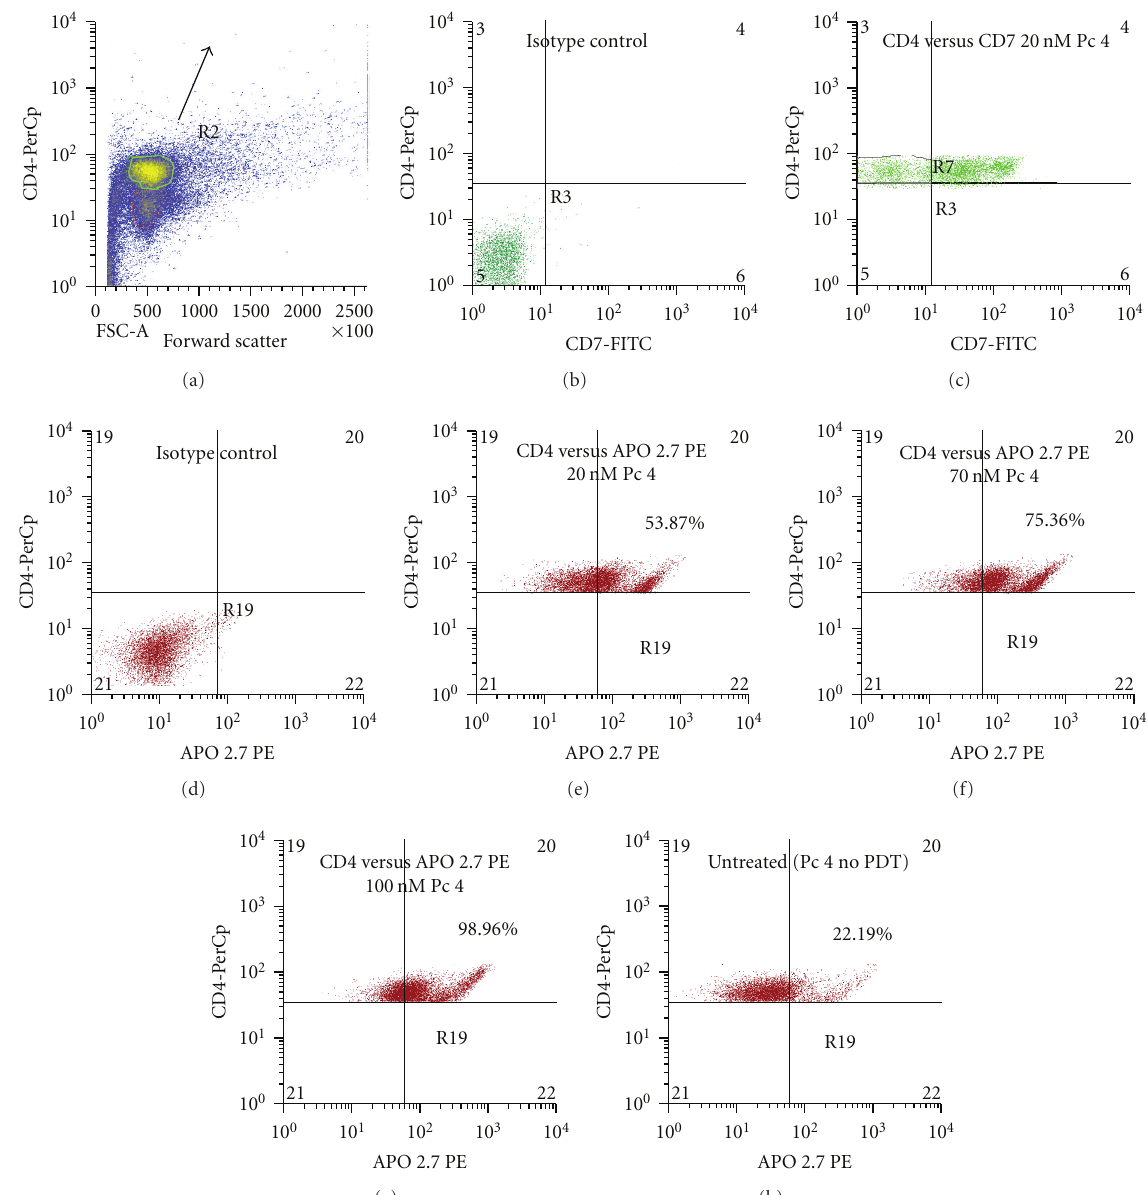
Figure 2: Representative flow cytometric histograms of the induced apoptosis of CD4 + CD7 − lymphocytes treated with Pc 4-PDT. Total blood was obtained from patients diagnosed with Sezary syndrome. The histograms shown were taken from a single patient with SS. PBMCs were isolated, treated with Pc 4, and stained as mentioned previously in the Methods section. Lymphocytes were identified by their high CD4 expression ( y -axis) and forward scatter ( x -axis) as shown in yellow (region R2) in (a). CD4 + CD7 − lymphocytes are shown in region R7 in (c). Levels of apoptosis in this population were analyzed in all three Pc 4-PDT doses. The data shown in (e), (f), and (g) exhibit a dose- dependent response in apoptosis induction among the three Pc 4-PDT concentrations. Levels of apoptosis in all three doses are significantly higher than in the untreated group shown in (h). Untreated cells were incubated with Pc 4 overnight but were not photo irradiated.